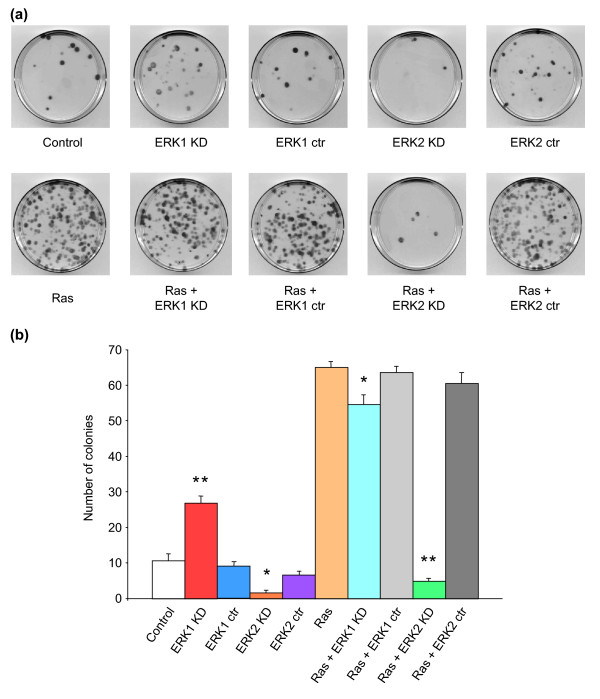
ERK1 knockdown in NIH 3T3 cells facilitates growth in colony formation assays, whereas ERK2 knockdown shows inhibitory effects. NIH 3T3 cells were transfected as indicated with the specific shRNA construct (KD) against ERK1 or ERK2 or the corresponding control sequence (ctr), all cloned into the pSUPER_Puro vector; cells were transfected either with shRNA alone or also with an oncogenic form of H-Ras (RasQ61L), and colony formation was scored after 10 days. (a) Representative plates; (b) graph of the number of colonies formed (the result of four independent experiments, expressed as mean ± SEM). Asterisks indicate a statistically significant genotype effect calculated from a post-hoc comparison in one-way ANOVA (Scheffe's test: control versus ERK1 KD; control versus ERK2 KD; RasQ61L versus RasQ61L-ERK1 KD; RasQ61L versus RasQ61L-ERK2 KD); single asterisk, p < 0.01; double asterisk, p < 0.0001.